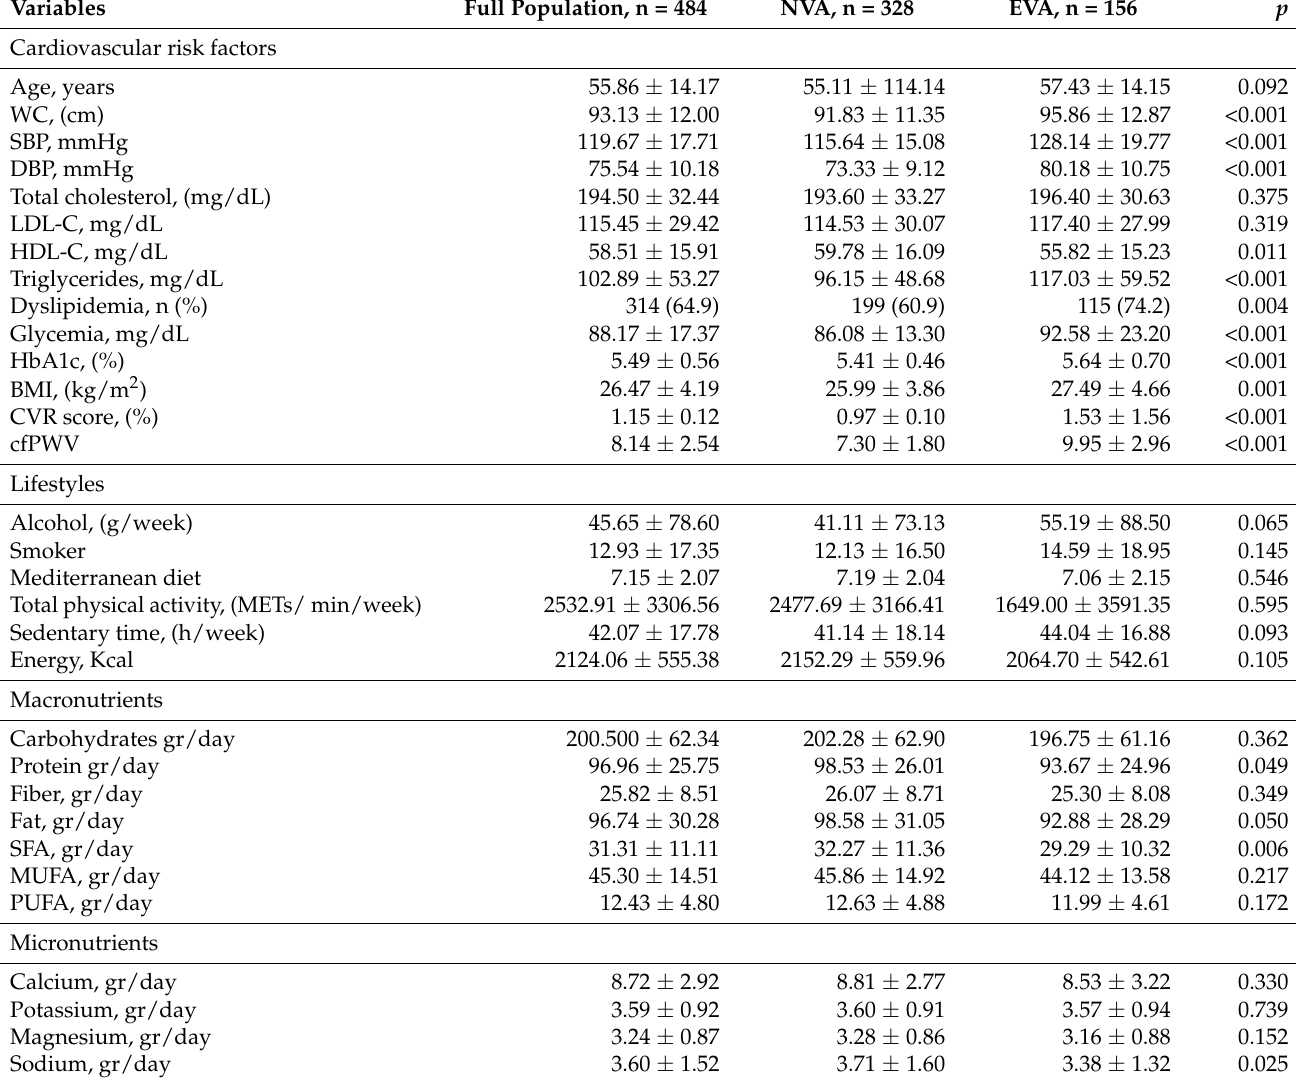
Table 2. Characteristics of participants with normal and early vascular aging using 75th